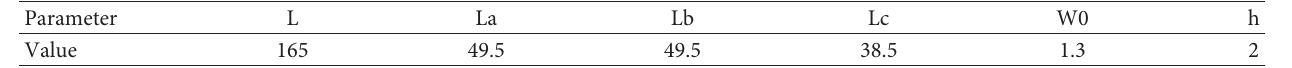
Table 2: Optimized four-branch antenna parameters (unit: